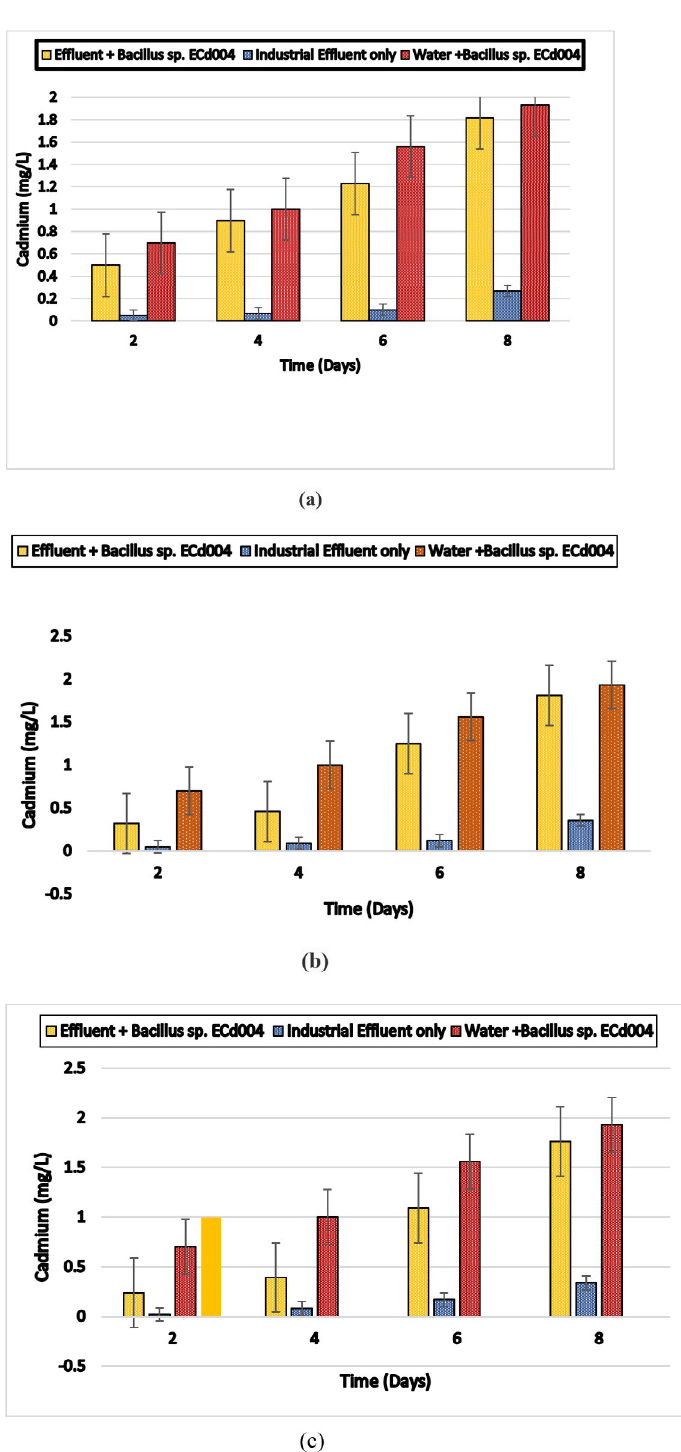
Fig. 5. Biosorption of Cadmium by a) Bacillus sp. ECd004 (Electroplating) b) Bacillus sp. ECd004 (Battery) c) Bacillus sp. ECd004